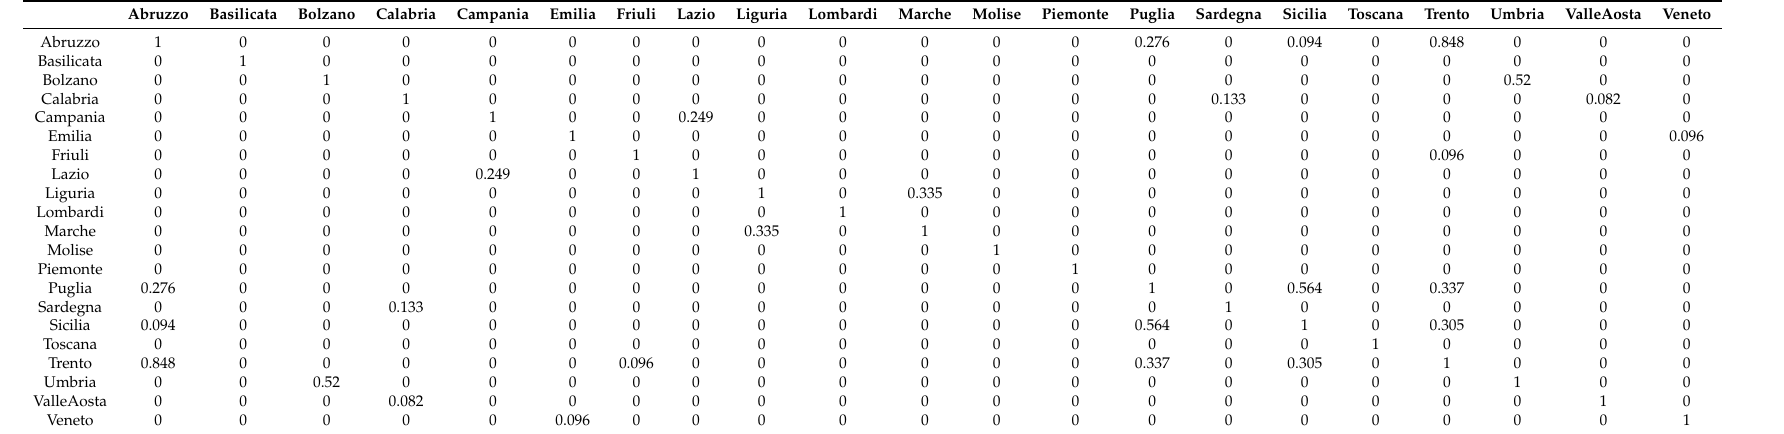
Table A12. Similarity values of Intensive Care network in the fifth